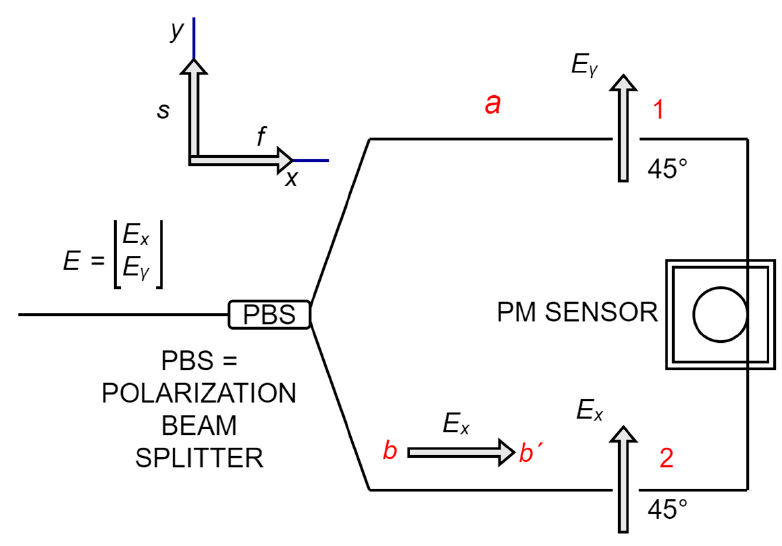
Figure 1. Basic arrangement of the sensor—a schematic overview. Notes 1 and 2 refer to the direction of light propagation (1 → 2) or (2 → 1).